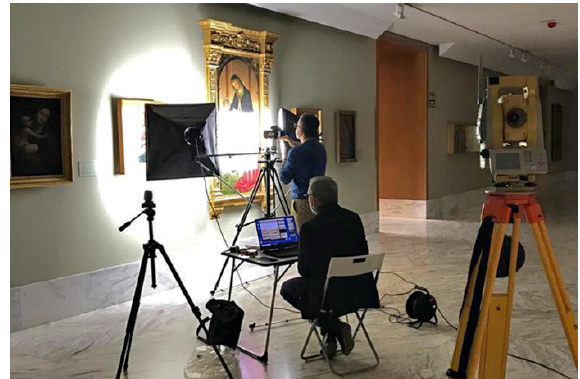
Figure 5 . Gigapixel photographic capture equipment.